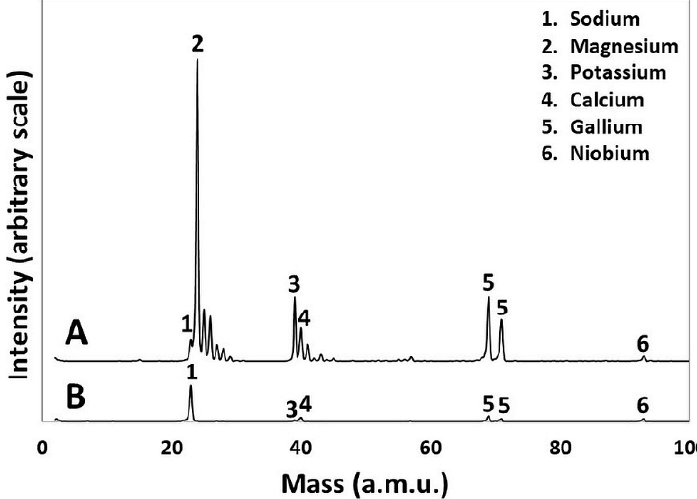
Fig. 8 . SIMS positive ion mass spectrum of the niobium coating surface: (A) as-received, (B) slightly polished. Note that the intensity of slightly polished specimen is not normalized in order to enhance